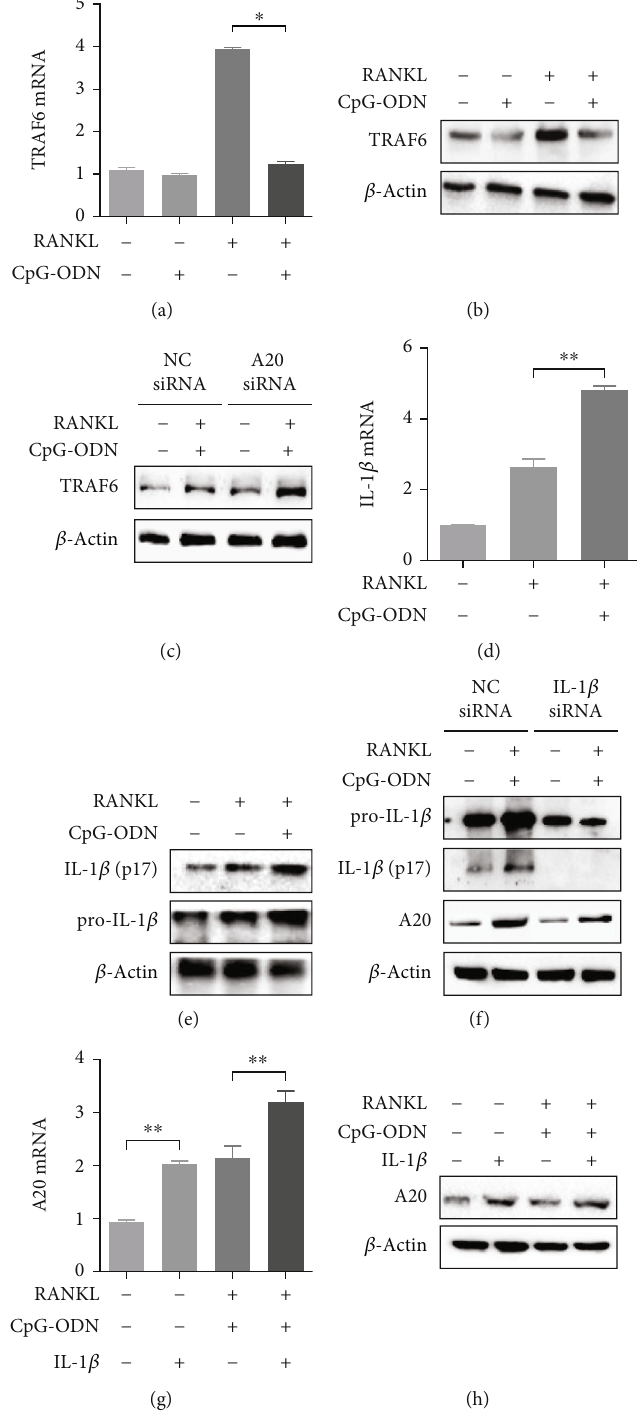
Figure 4: CpG-ODN is involved in the regulation of TRAF6, A20, and IL-1 β . (a, b) TRAF6 mRNA and protein expression in RAW 264.7 cells under stimulation with either RANKL or CpG-ODN and both. (c) Under the same conditions, TRAF6 protein expression was measured in A20 de fi cient cells. (d, e) IL-1 β mRNA and protein expression were augmented by CpG-ODN in the presence of RANKL. (f) IL-1 β protein expression in cells transfected with A20 siRNA under stimulation with either RANKL or CpG-ODN and both. (g, h) A20 expression was measured in cells under stimulation with both RANKL and CpG-ODN by addition of IL-1 β (10 ng/ml). Abbreviation: NC: negative control; IL-1 β : interleukin-1 β . Error bars represent standard deviation of the measurement of three separate samples ( ∗ p < 0 : 001 and ∗∗ p < 0 : 05